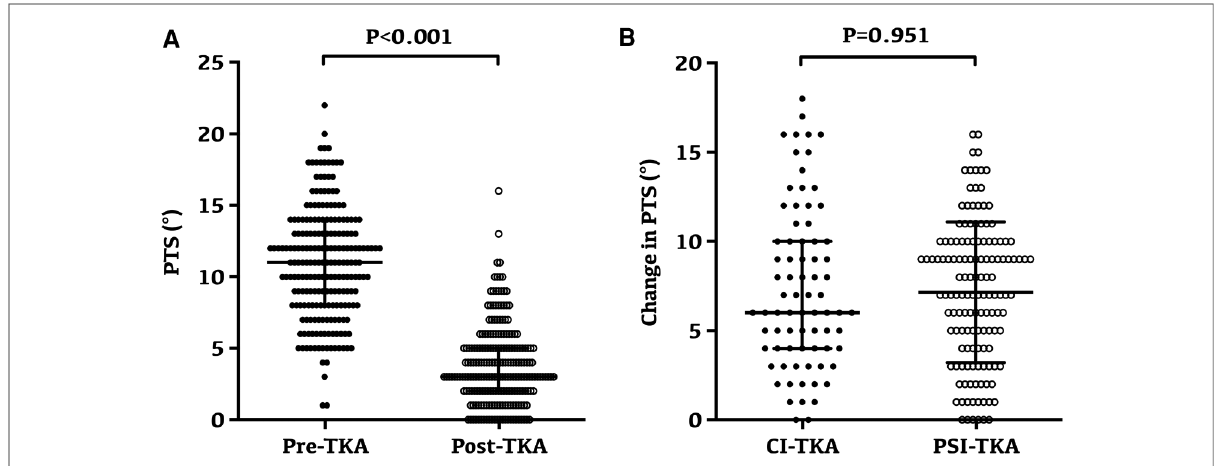
FIGURE 5 Changes and variability of posterior tibial slope following TKA. ( A ) Preoperative and postoperative posterior tibial slope for all patients; the posterior tibial slope was 10.92°±3.88° preoperatively and reduced to 3.78°±2.79° after TKA ( p <0.001). ( B ) No signi fi cant difference in the change of PTS after TKA between the two groups ( p